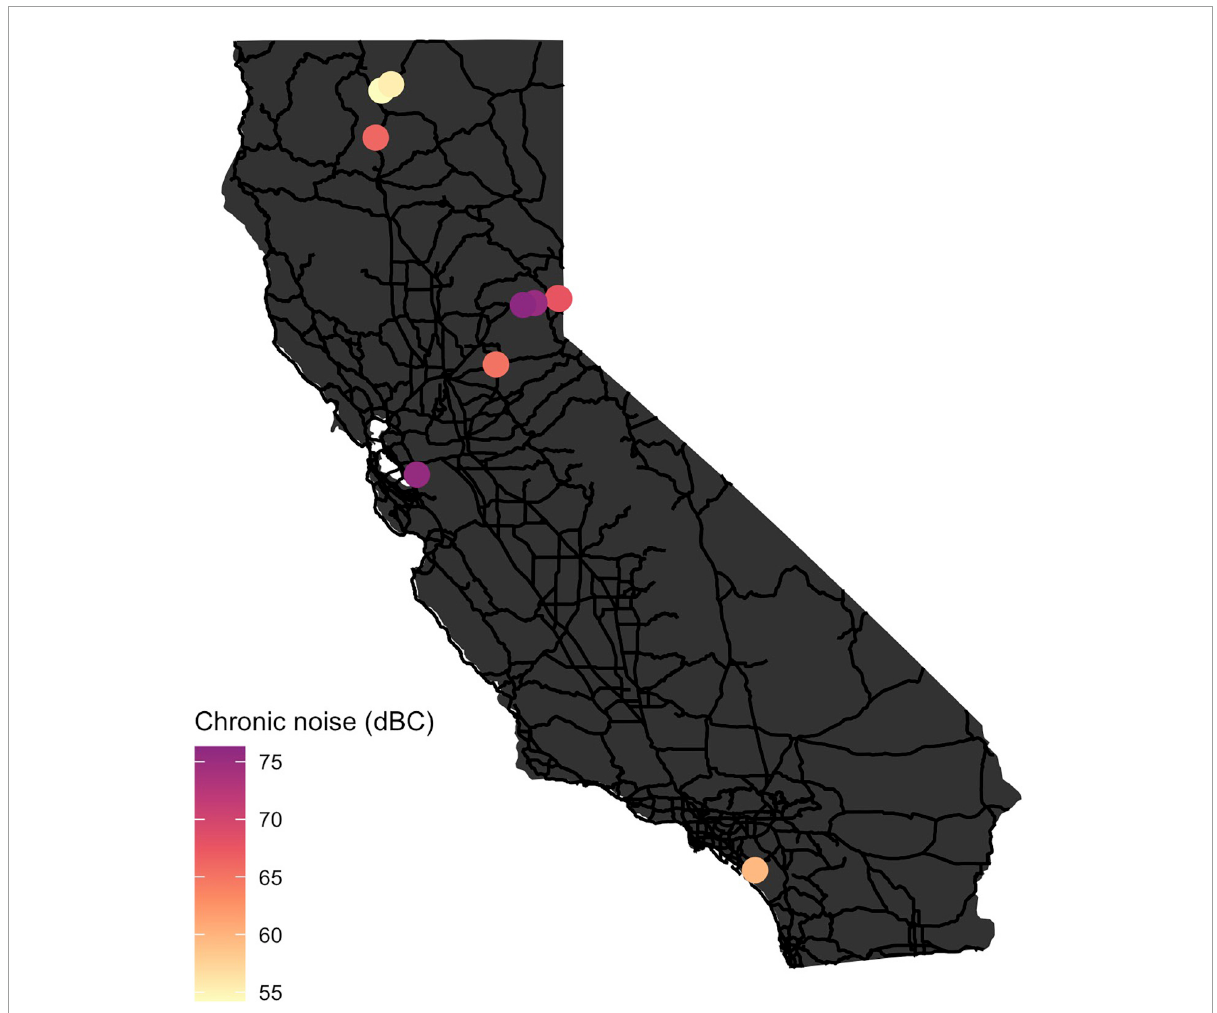
FIGURE1 Map of California State Highways (black lines) and the location of each crossing structure sampled in this study (circles). Color of each crossing structure represents the level of chronic noise recorded (1-week